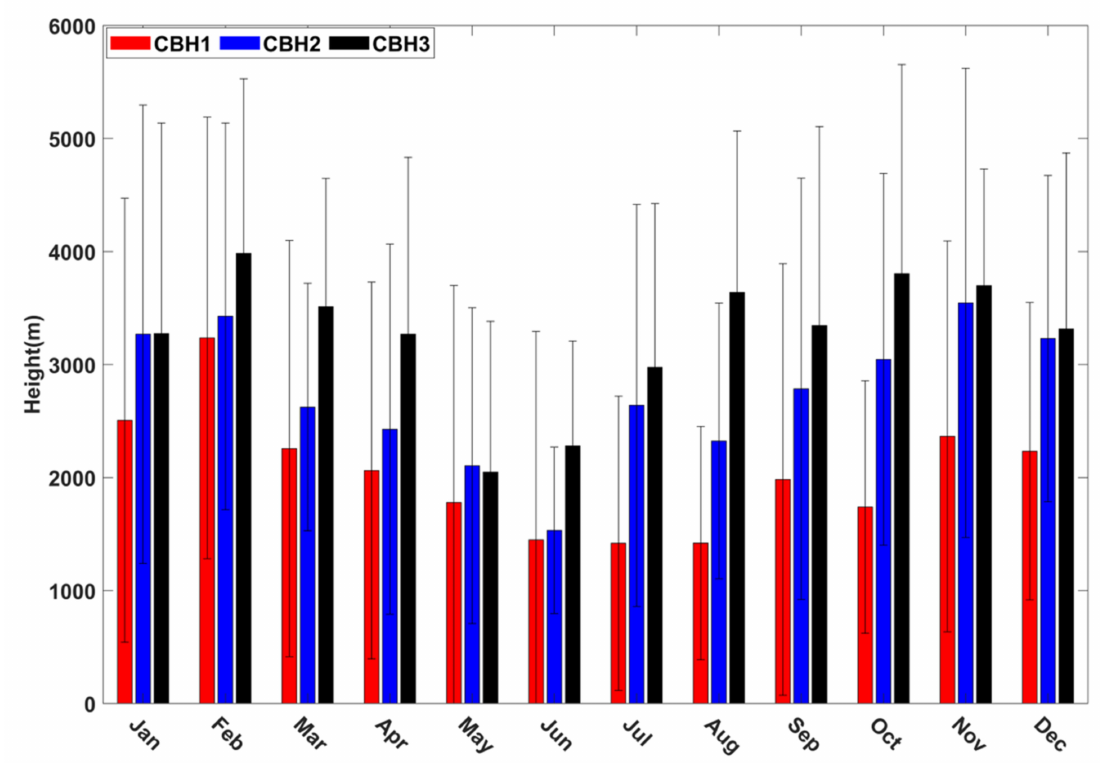
Figure 4. Monthly mean CBH heights for the three layers detected by the ceilometer. The error bars indicate one standard deviation